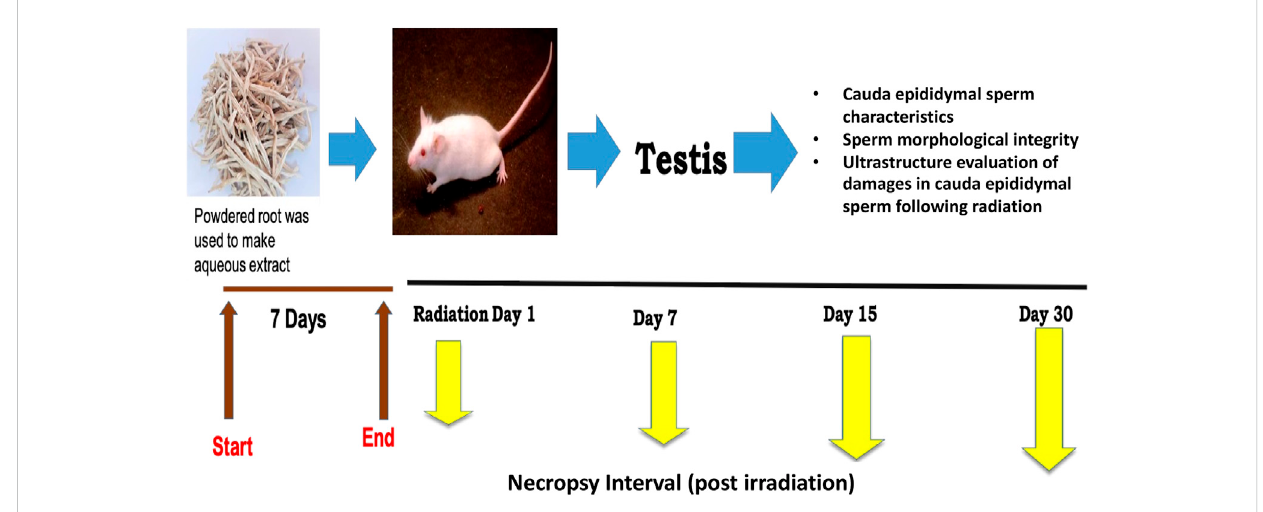
FIGURE 1 Study design and experimental groups along with measurement